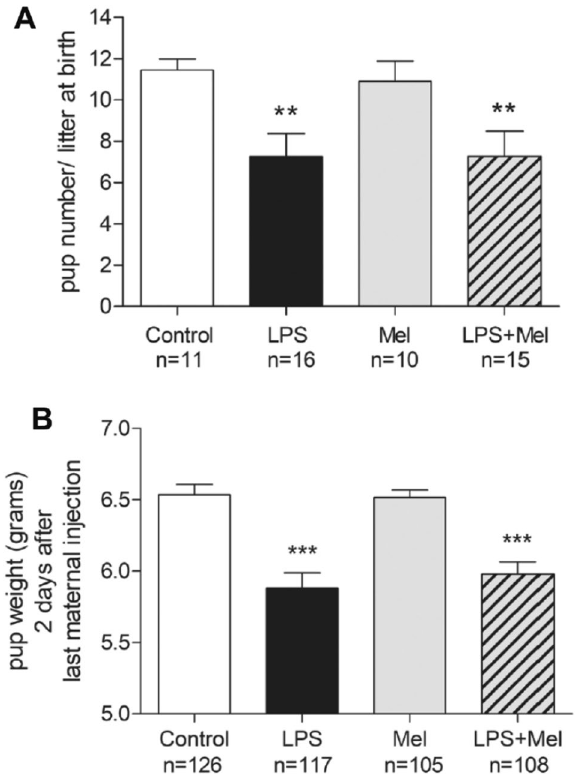
Figure 1. LPS injections to pregnant rats induced a reduction of pup number and pup weight at PND1 irrespective to melatonin exposure. ( A ) Graphic representation of the pup number per litter according to the experimental treatment. ( B ) Graphic representation of pup weight in grams at PND1, 2 days after the last maternal injection, according to the experimental treatment. White, black, grey and hatched grey bars represented the Control, the liposaccharide portion of the E. coli membrane (LPS), the melatonin (Mel) and the LPS + Mel groups, respectively. Results are expressed as mean ± standard deviation. Statistical analysis: One- Way-ANOVA test was performed associated with Bonferroni post-test, * p < 0.05 and *** p < 0.001 in comparison with the Control